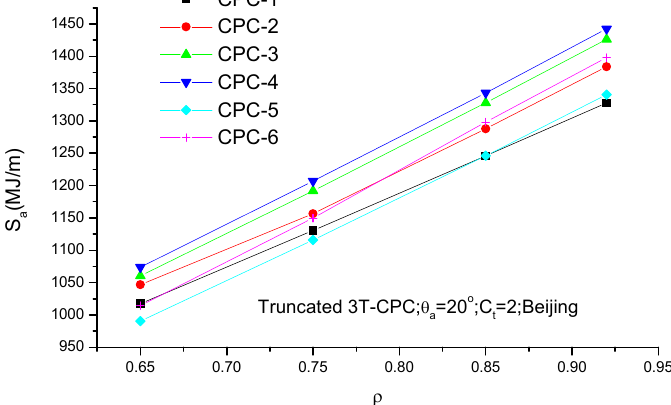
Figure 13. As in Figure 10 but for truncated 3T ‐ CPCs.